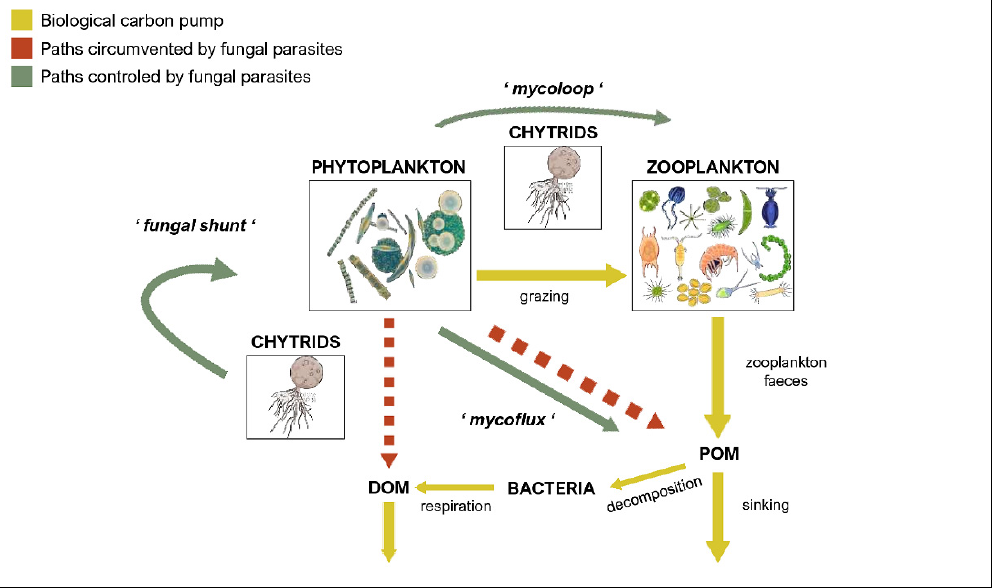
Figure 1. Fungal parasites are key components of the biological carbon pump. Fungal parasites take up phytoplankton-derived photosynthetic carbon (‘fungal shunt’) and thus lower the contribution to the DOM and POM pools. Through ‘mycoflux’, fungi control POM aggregation process, either decreasing (parasitic fungi), or increasing (saprotrophic fungi) the aggregation rate by promoting active aggregation via hyphae growth. Via fragmentation of large phytoplankton cells and redirecting carbon directly to zooplankton (‘mycoloop’) they can also indirectly modulate carbon sequestration via sinking zooplankton faeces.